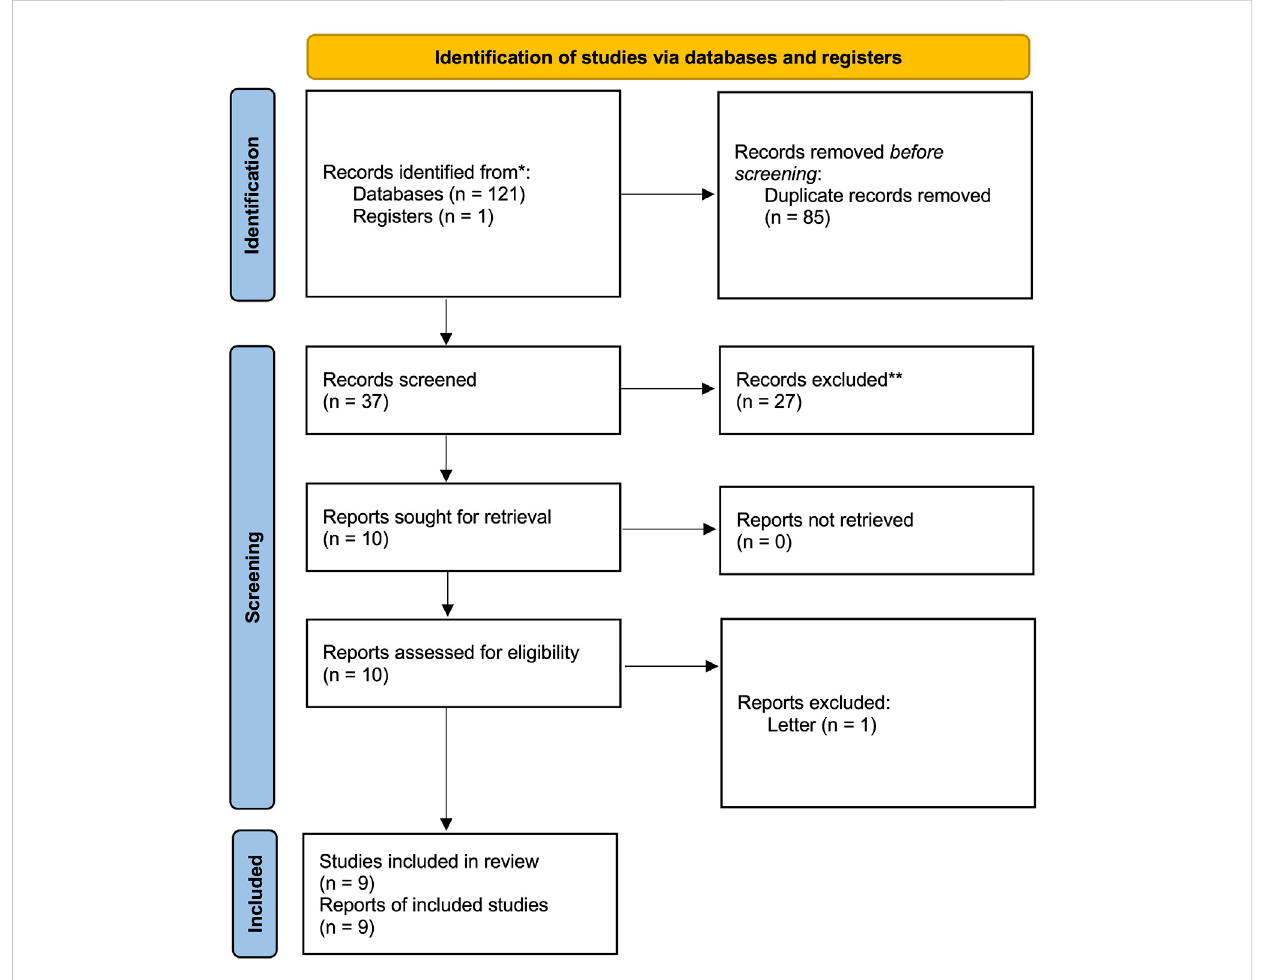
FIGURE 1 PRISMA 2020